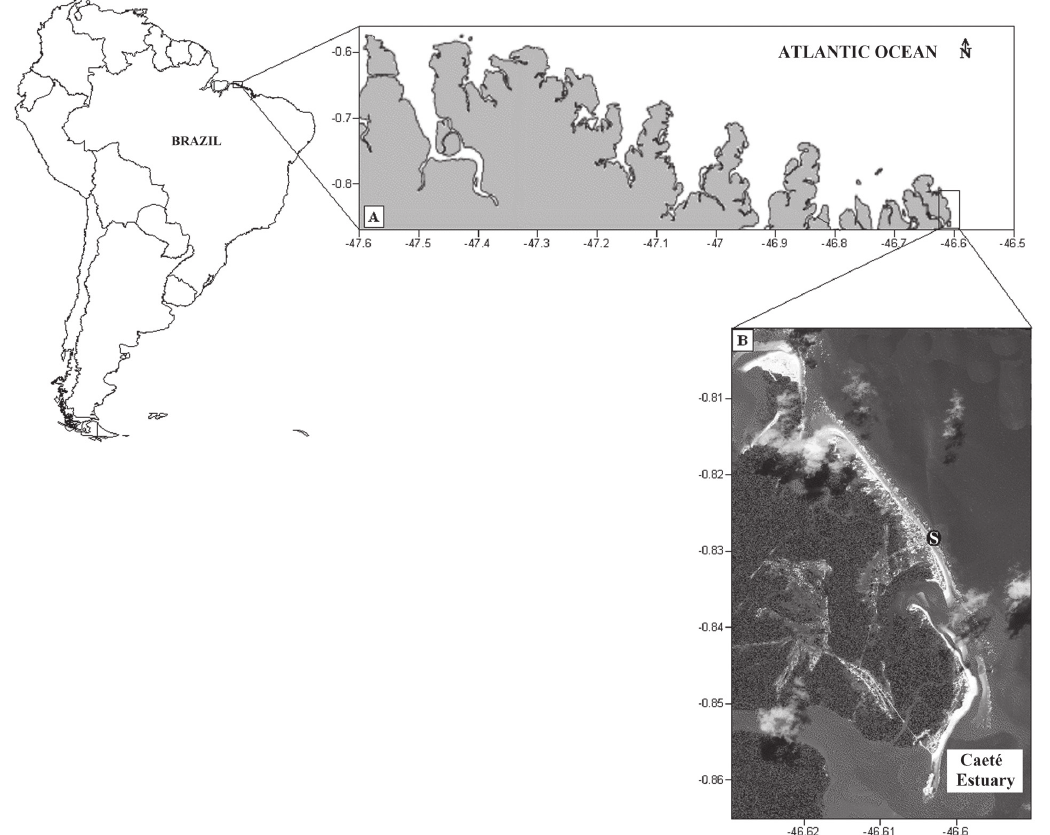
Figure 1 - Study area: (A) Municipality of Bragança, Pará, Brazil; (B) Ajuruteua beach (Northeastern Pará), showing the location of the fixed sampling station (black symbol - Modified from Sousa et al.